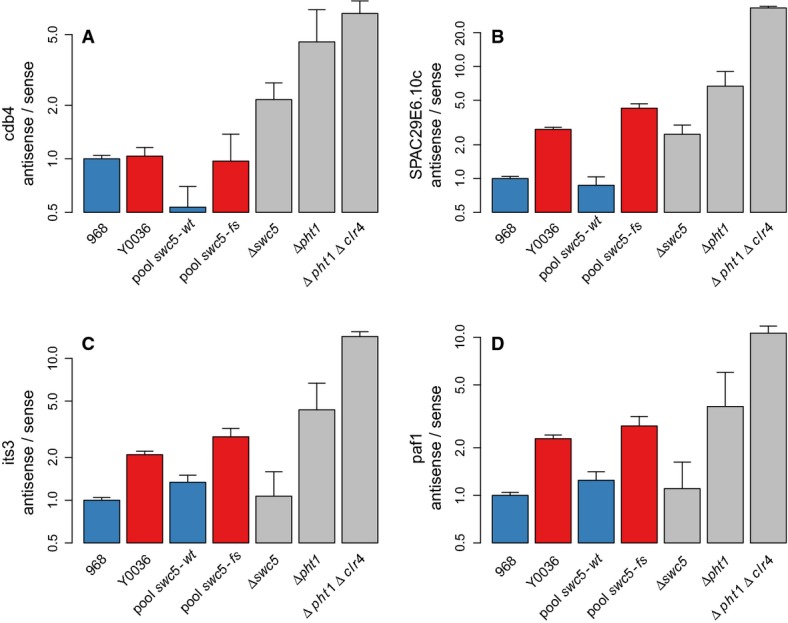
Strand-specific semi-quantitative real-time PCR quantification of sense and antisense levels
of selected targets of swc5 locusA–D y-axis shows the ratio of antisense-to-sense levels relative to ratio
in 968 strain (log scale). Error bars indicate the standard error to the mean among the three
biological replicates. Analysis was performed for four genes: cdb4 (A),
SPAC29E6.10c (B), its3 (C), paf1 (D) in seven
different strains: the two parental strains (968, Y0036), two pools of strains corresponding to all
the segregants separated according to their genotype at the swc5 locus, and strains
deleted for swc5, pht1, and both pht1 and
clr4. No difference was observed between the parents in cdb4,
which indicates that other genetic events are implicated, as expected since cdb4 is
also associated with another aseQTL (Supplementary Information). For paf1 and
its3, effects observed in swc5-fs strains (pool and Y0036) were
not observed in Δswc5. This may be due to other genetic effects in
cis of swc5, or to effects of auxotrophic and mating makers which
differ between 968 and Δswc5 (Supplementary Information).